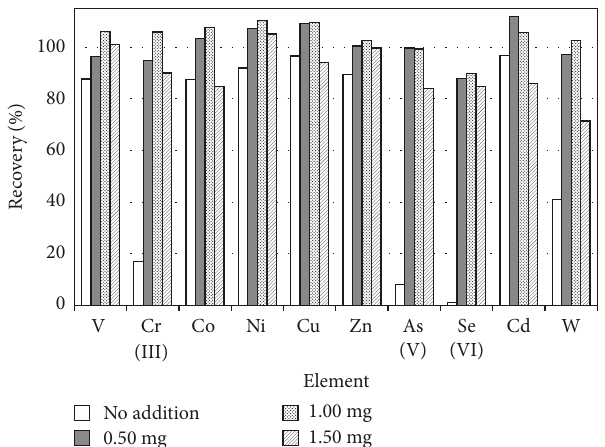
Figure 1: Comparison of recoveries of V, Cr(III), Co, Ni, Cu, Zn, As(V), Se(IV), Cd, and W in changing the added amount of Fe 3+ in the hybrid